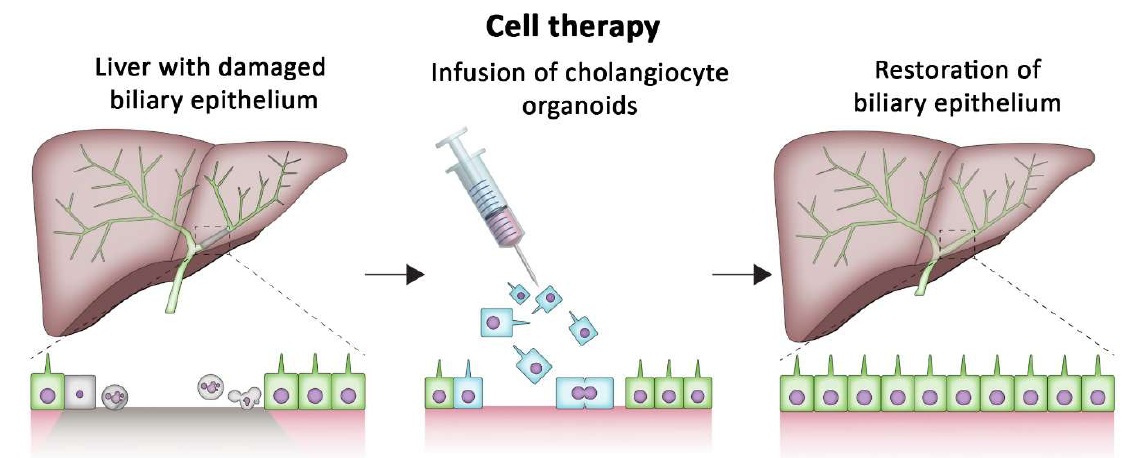
Figure 2. Cholangiocyte organoids can repair deficits in the biliary epithelium. This treatment can restore adequate drainage of bile and prevent build-up of toxic bile inside the liver. Cholangiocyte organoids can be infused into the biliary tree to repair the damaged biliary tree.